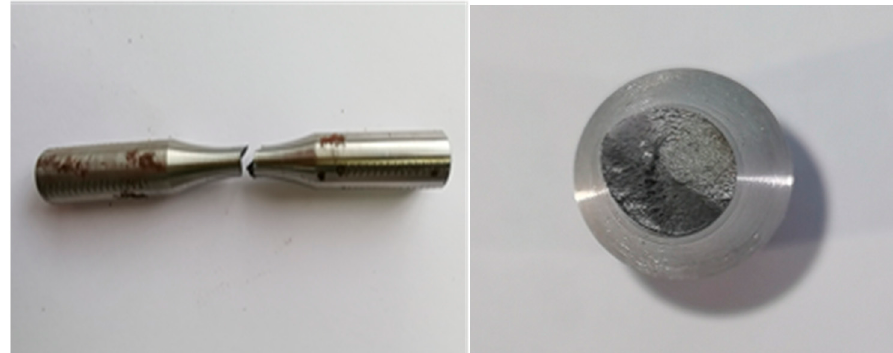
Figure 1. Test piece size.